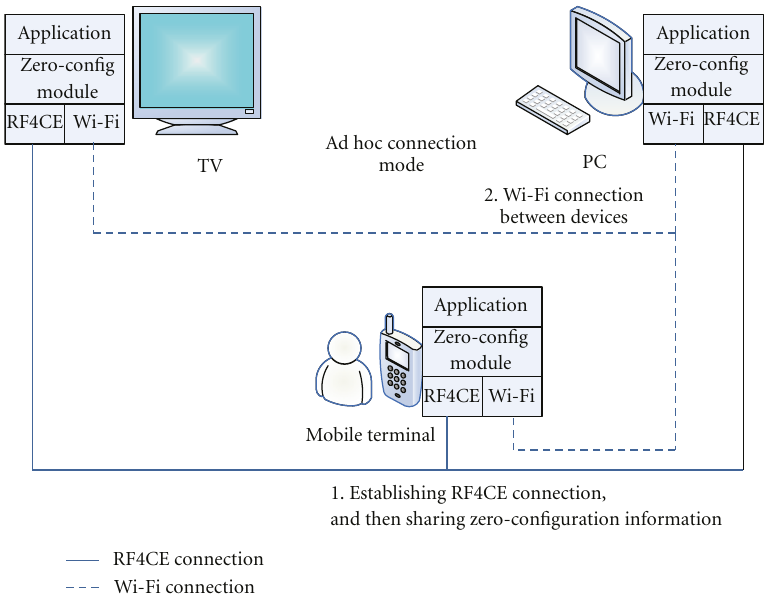
Figure 3: Ad hoc connection mode in zero configuration